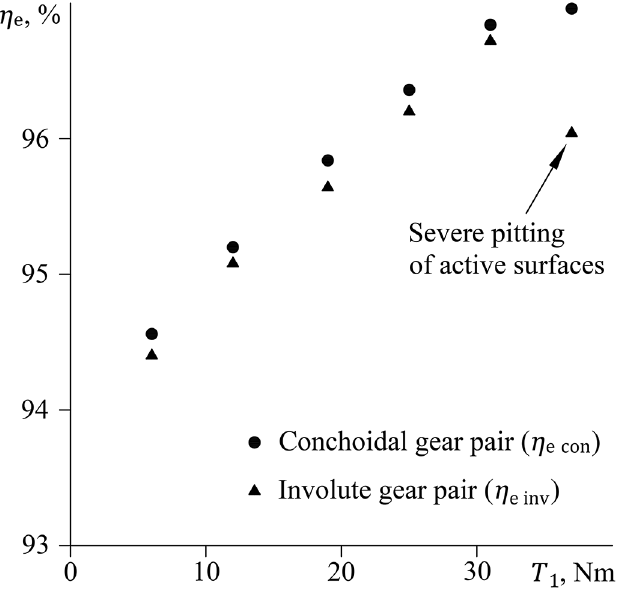
Fig. 7. Gear test rig energy ef fi ciency h e vs pinion torque T 1